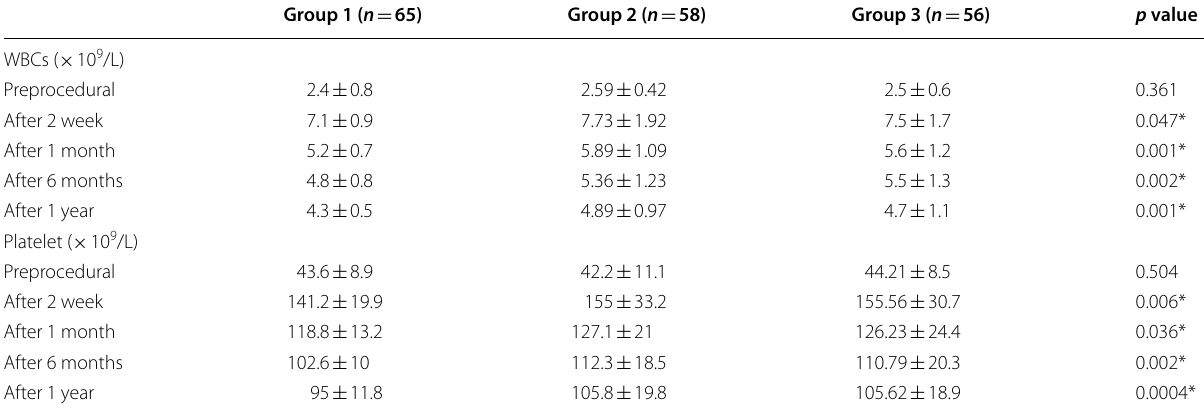
Data represent the mean